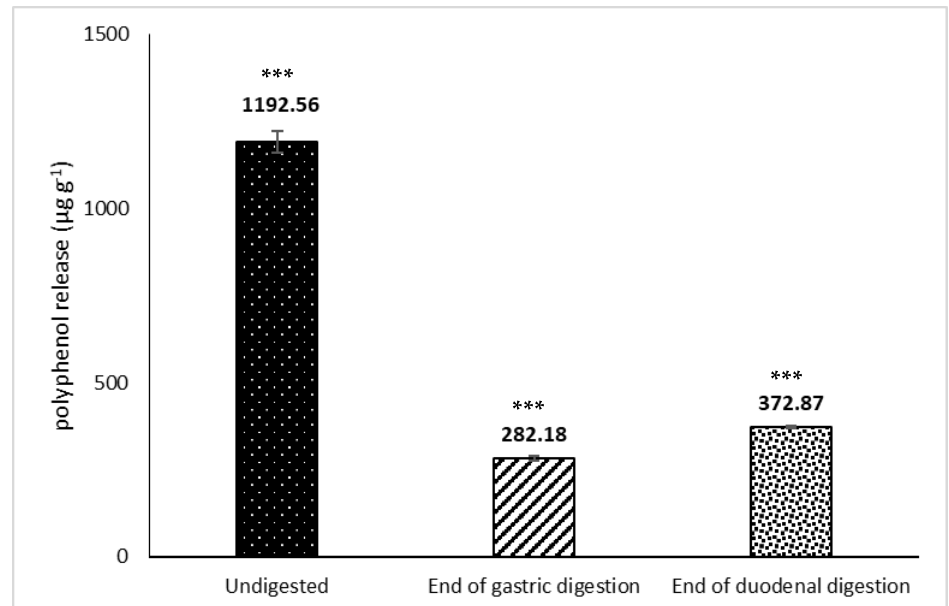
Figure 4. Evaluation of total polyphenols content in the extract at the end of gastric and duodenal digestion. Values are given as the amount of polyphenols in the undigested extract (baseline) and in the soluble extract released during in vitro gastric and gastric + duodenal digestion. Values represent averages (±SD) of triplicate measurements. RSD was always <10%. Statistically significant differences were observed (Friedman’s test followed by post hoc comparison with one-tailed Dunnett’s test) and are characterized by the * symbol. Statistically significant differences were observed between the end of gastric and duodenal digestions and undigested extract ( p < 0.001) (***).